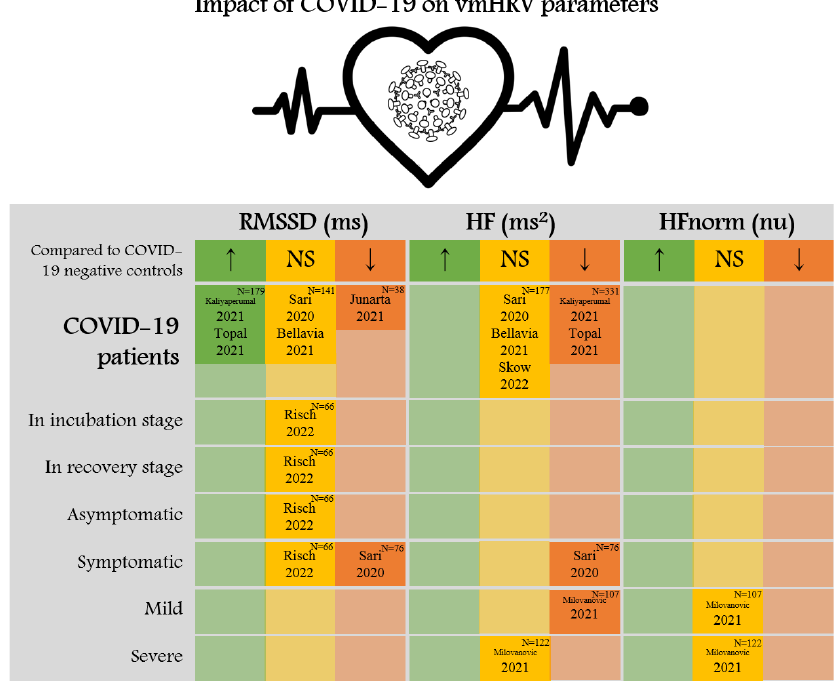
Figure 2. Impact of COVID-19 on vmHRV parameters [49,51,54,55,59,61,64,65]. Abbreviations: COVID-19, coronavirus disease of 2019; HF, high frequency; HFnorm, normalized unit of high frequency power; HRV, heart rate variability; NS, not significant; RMSSD, the square root of the mean squared differences of successive NN intervals; vmHRV, vagally mediated heart rate varia- bility. Note: The number (N) in the upper right corner of each cell means the number of partici- pants included in the analysis. ‘ ↑ ’ (green shading) and ‘ ↓ ’ (orange shading) mean significantly higher or lower than that of COVID-19 negative controls, respectively, while ‘ NS ’ (yellow shading) indicates no statistically significant difference was found.